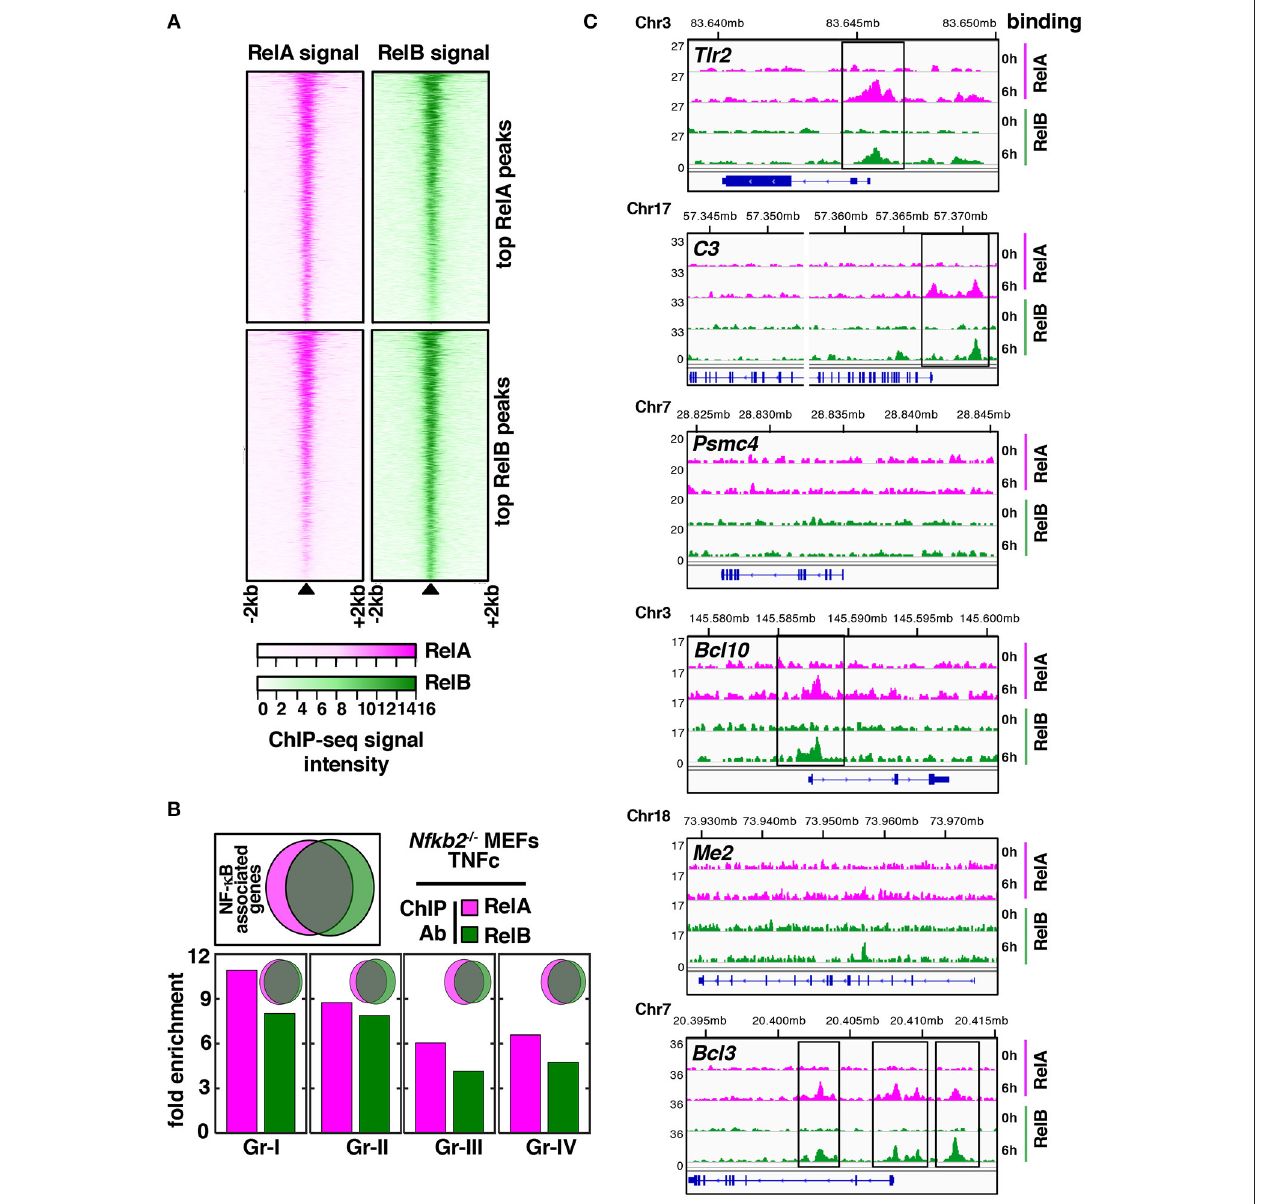
FIGURE 5 | Overlapping genome-wide distributions of RelA and RelB in TNF-stimulated Nfkb2 − / − MEFs. (A) Using ChIP-seq analyses, we captured the genome-wide distribution of RelA and RelB in Nfkb2 − / − MEFs subjected to TNFc treatment for 6h. A peak centered heatmap revealing RelA and RelB binding to chromatin locations surrounding top RelA or top RelB binding peaks. (B) Venn diagrams reveal overlap between RelA- (magenta) and RelB-associated (green) genes globally (top, left) or for the individual gene groups. Bar graphs reveal relative enrichment of RelA-associated and RelB-associated genes for various gene groups. (C) Representative browser tracks of RelA and RelB binding to genes belonging to various gene groups. The y-axis represents normalized reads per 10 million. Chromosomal locations of each gene in mm9 are shown above ChIP-seq